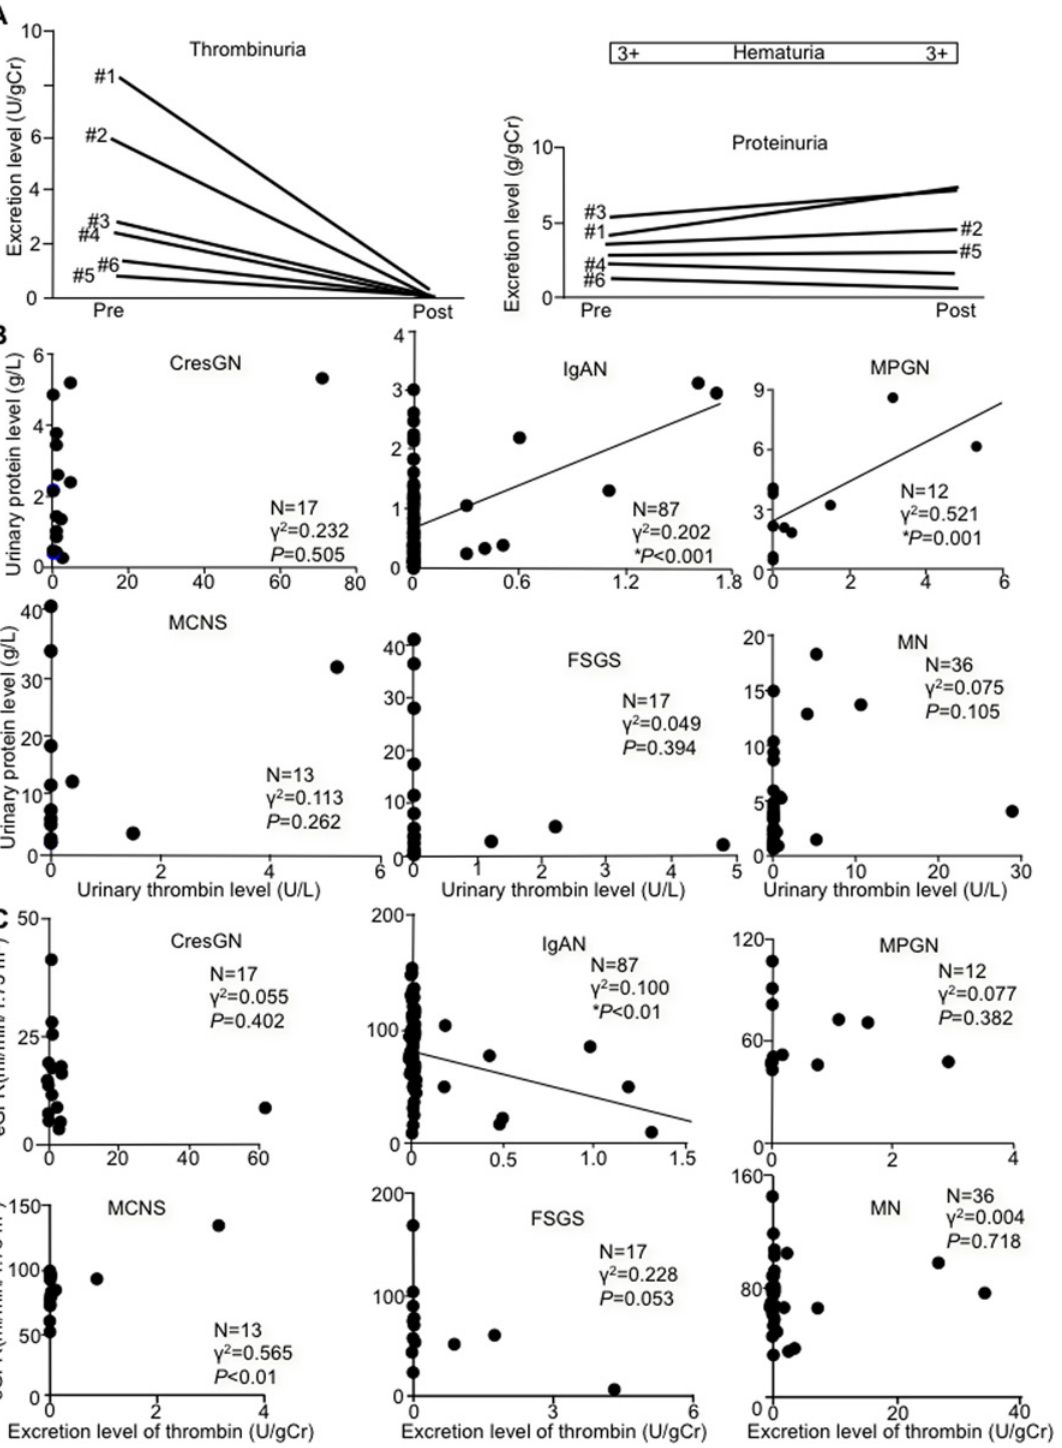
Fig 3. Glucocorticoid effect on thrombinuria and proteinuria and thrombinuria vs. proteinuria or estimated glomerular filtration rate. ( A ) Thrombinuria (left panel) and proteinuria and hematuria (right panel) before (pre) and after (post) steroid pulse treatment in 6 patients with crescentic glomerulonephritis (CresGN) (#1 to #6) with thrombinuria. Three days of pulse therapy with intravenous methylprednisolone at 0.5 – 1 g/day was followed by oral prednisolone at 20 – 30 mg/day. gCr indicates gram of urinary creatinine. ( B ) Relation between urinary thrombin and urinary protein levels for various types of glomerulonephritis. Each circle represents an individual patient. ( C ) Relation between excretion level of thrombin and estimated glomerular filtration